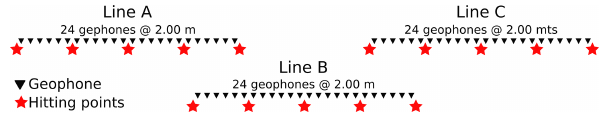
Figure 3. Implemented arrangement for the measurements across the ground discontinuities.